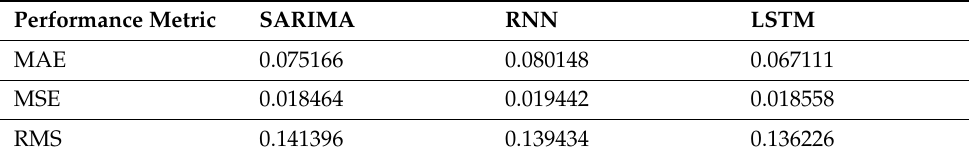
Table 1. Performance metric comparison among the three algorithms.